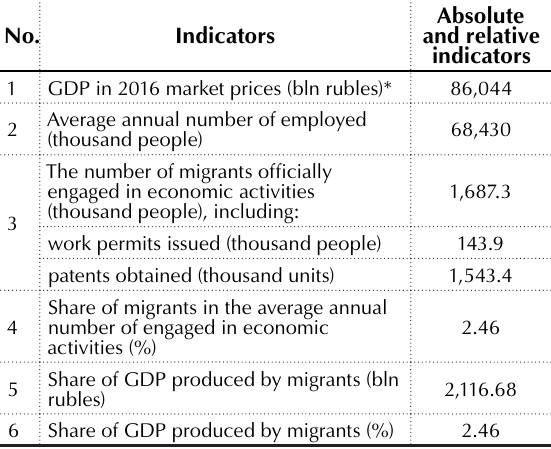
Table 3. Number and share of Russia’ GDP produced by legal migrants in